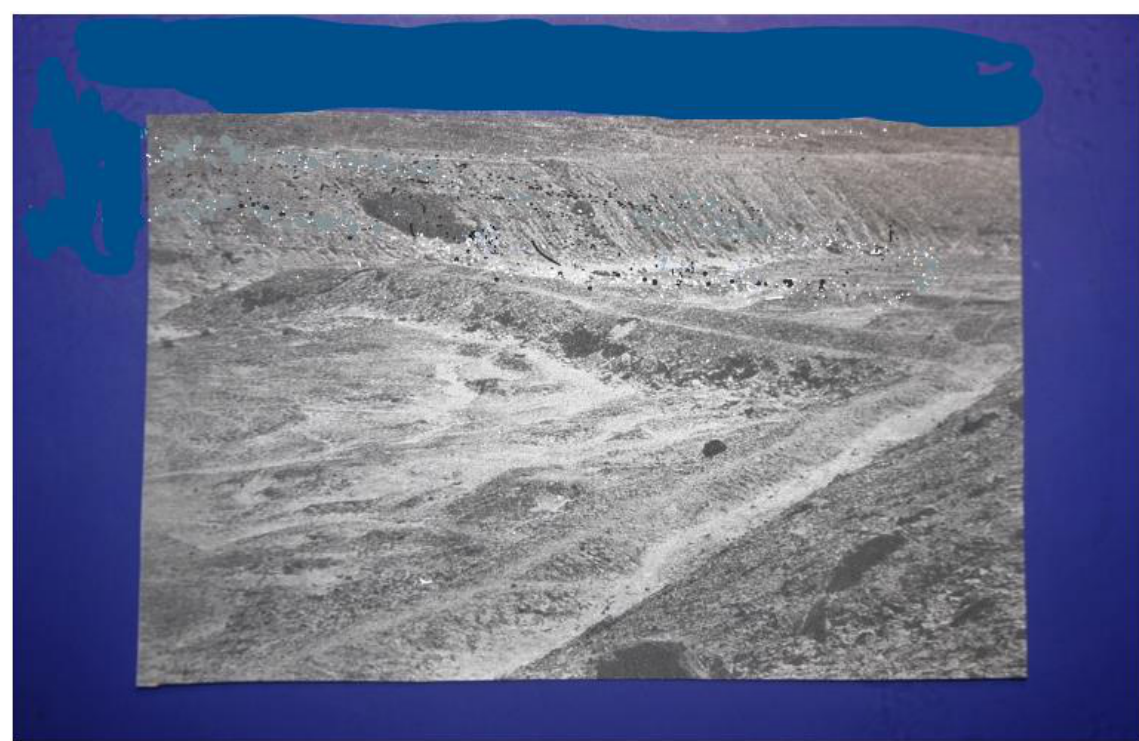
Figure 9. The low-height Hoya Hondada Aqueduct viewed from the northern embankment. The aqueduct channel proceeds downhill along the southern bank of the quebrada to a plateau with Moche and Chimú settlements. Figure from [1], p. 115. Photo by author at site in Peru.